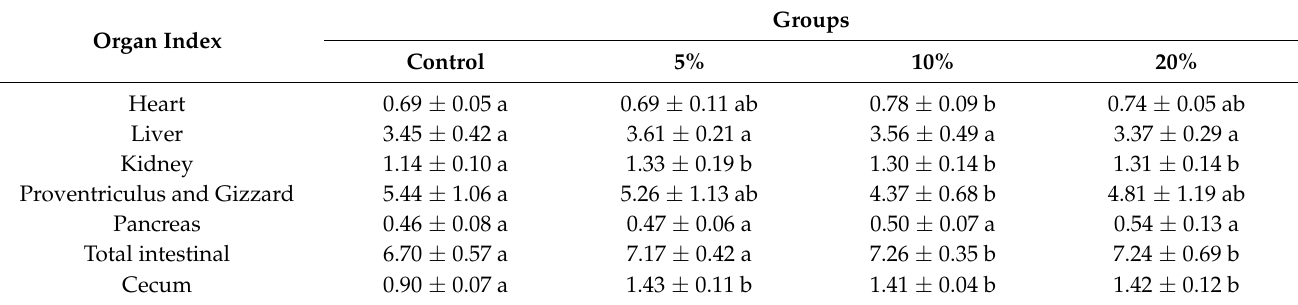
Table 4. The effect of FTWW on the index of the metabolic and digestive organs of the chicks.